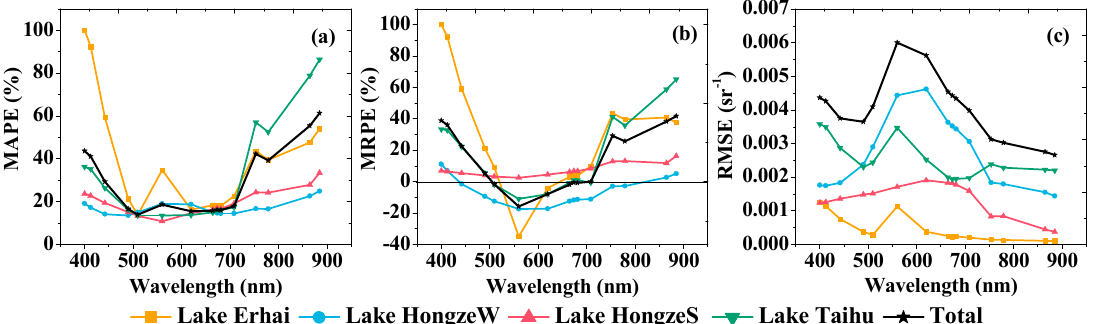
Figure 7. OLCI-derived R rs (sr − 1 ) versus measured in situ R rs (sr − 1 ) at 15 bands with central wavelengths of 400, 412.5, 442.5, 490, 510, 560, 620, 665, 673.75, 681.25, 708.75, 753.75, 778.75, 865, and 885 nm. Respective bands are denoted by symbols. The solid black lines represent the 1:1 line. The dashed lines represent the regression lines.